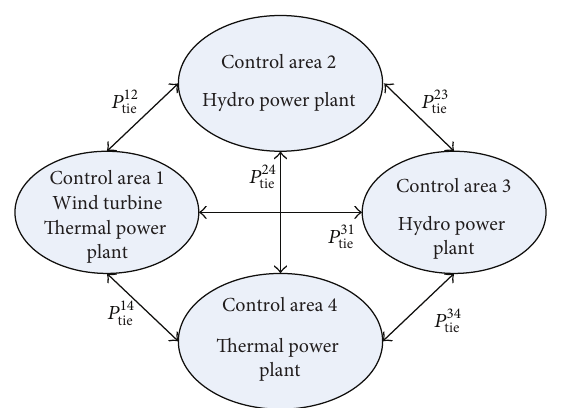
Figure 1: The four-area interconnected hybrid power system.